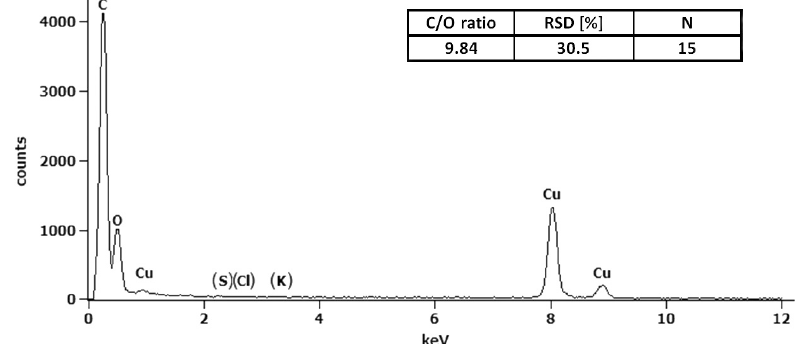
Figure 4. Typical EDS spectrum from a laboratory-generated tar-ball particle and the average C/O molar ratio of 15 measured particles. (The copper peaks are artifacts that originate from the supporting grid.)